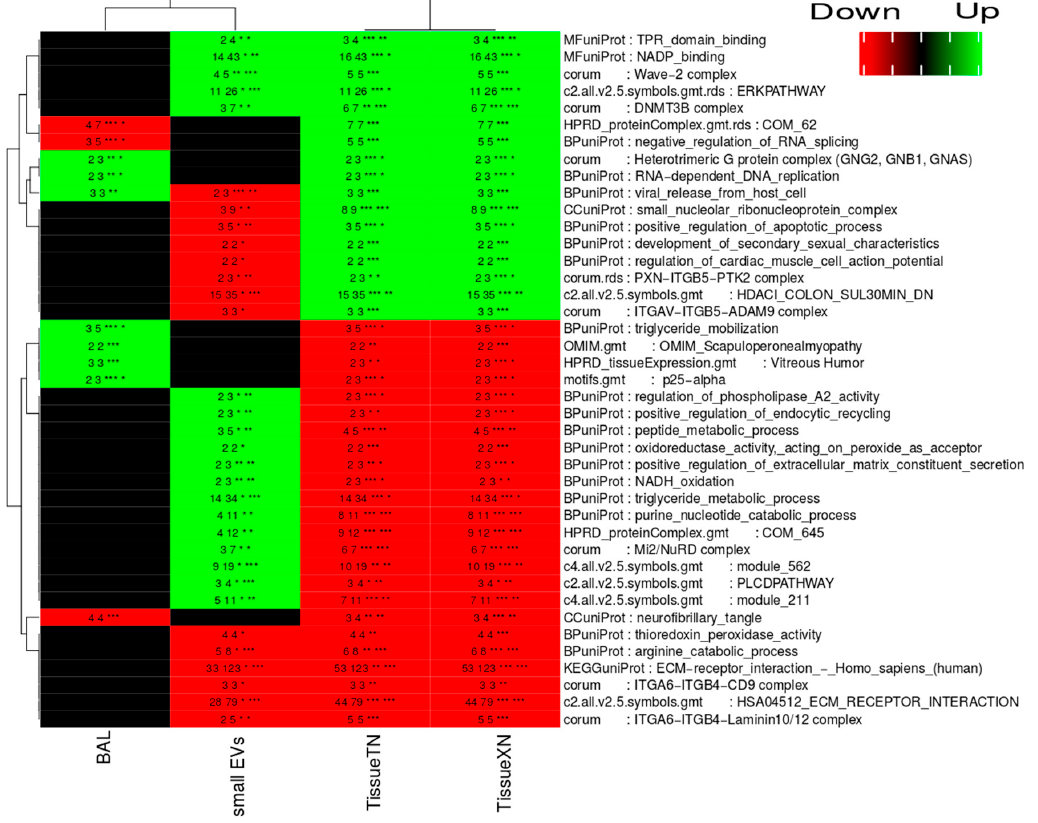
Figure 5. Complete functional regulation and enrichment analysis of proteins identified in acellular BAL (BAL), small EVs, lung tumor tissue (TissueTN), and xenotransplant lung tumor tissue (TissueXN). The color code in the heatmap reflects the regulation level (black unregulated, green significant up-regulated in tumor, and red significantly down-regulated in tumor). The text in the cells indicates the number of proteins identified in each functional category, the number of proteins annotated in the given functional category and the significance level of regulation, and significance level of enrichment (* p < 0.05, ** p < 0.01, and *** p < 0.001).